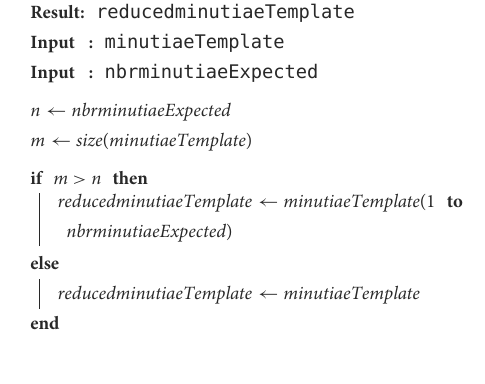
Algorithm 1. Truncation method.